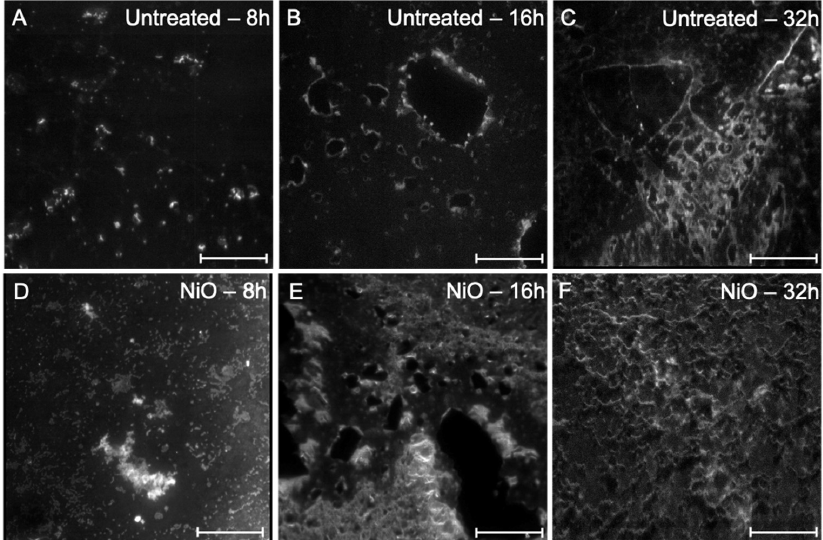
Figure 7. Light sheet microscopy images of P. aeruginosa biofilm formation on coverslips. Panels ( A – C ) show the biofilm formation at different time points in the LB medium alone. Panels ( D – F ) show the biofilm formation in the presence of NiO NPs on the coverslip in LB medium. The direct comparison at different stages clearly demonstrates that the P. aeruginosa formed a more drastic biofilm in the presence of NPs. Scalebar = 500 µ m.